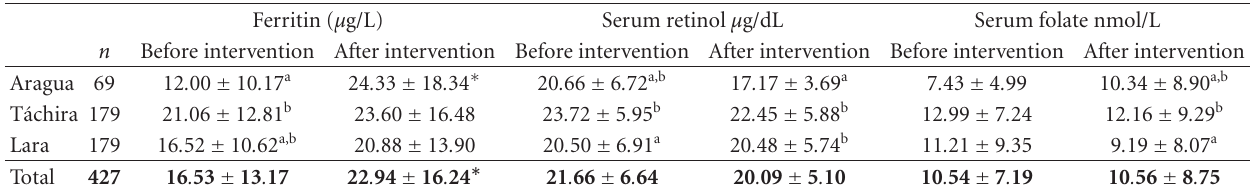
Table 3: Changes in ferritin, retinol, and folate concentrations in children before and after the intervention of nutritional education in schools from Aragua, T´achira, and Lara States, Venezuela. Classification by State of precedence. Ferritin ( µ g/L)